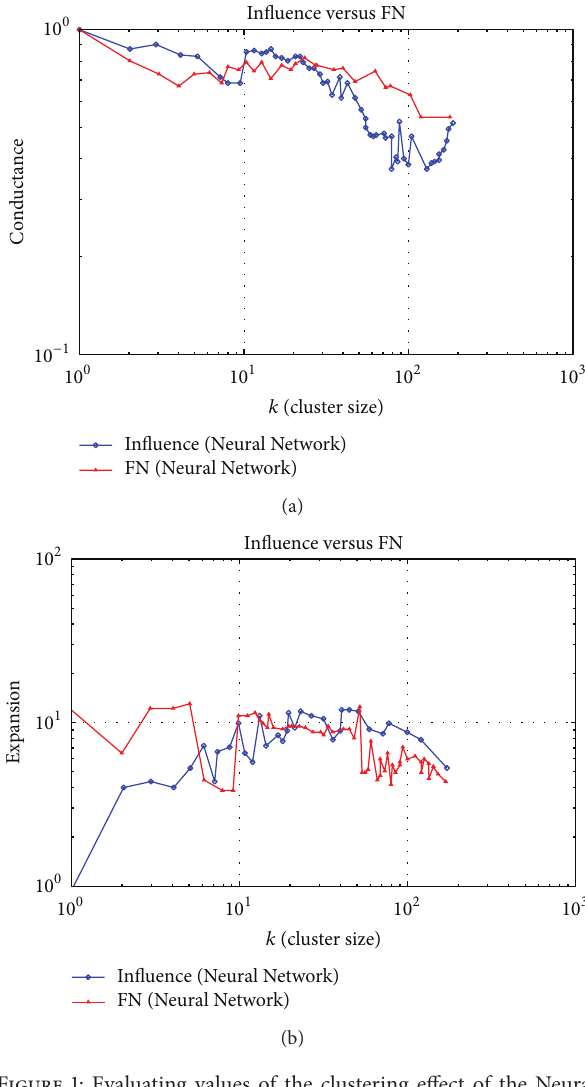
Figure 1: Evaluating values of the clustering effect of the Neural Network